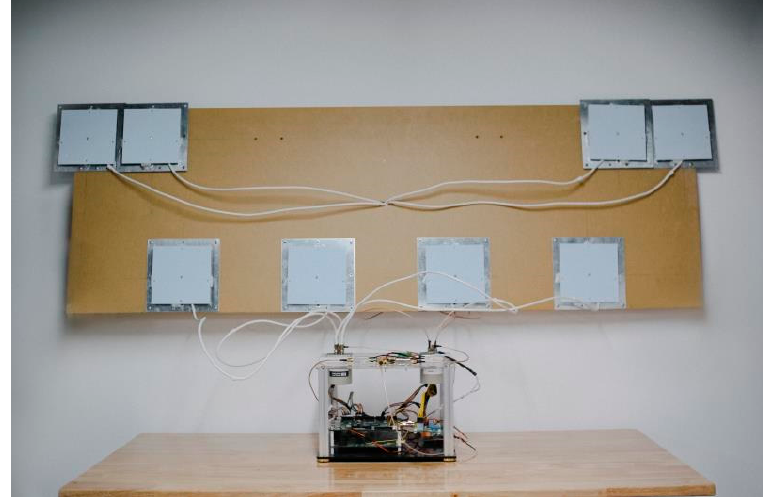
Figure 7. MIMO radar system.